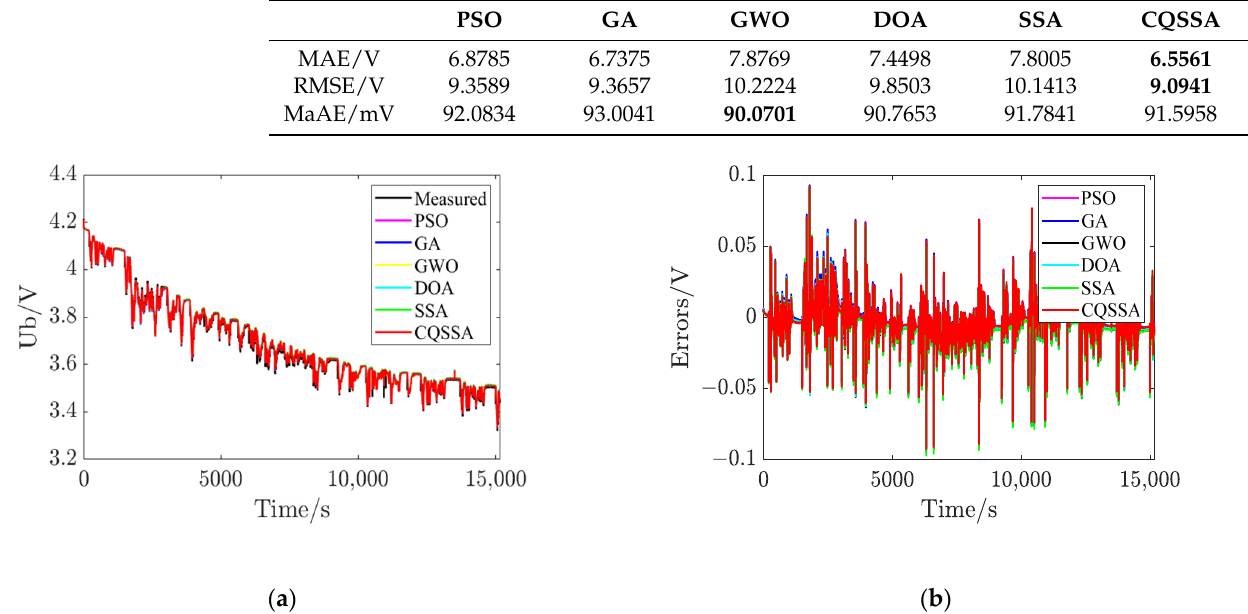
Figure 8. The comparison of estimated and measured voltages under UDDS test. ( a ) The compari- son of measured and estimated terminal voltages. ( b ) The comparison of terminal voltage errors of six